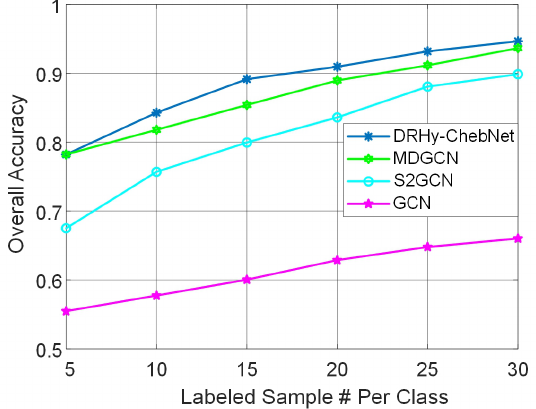
Figure 6. Overall accuracies of the GCN-based methods versus different numbers of labeled samples on the Indian Pines dataset.